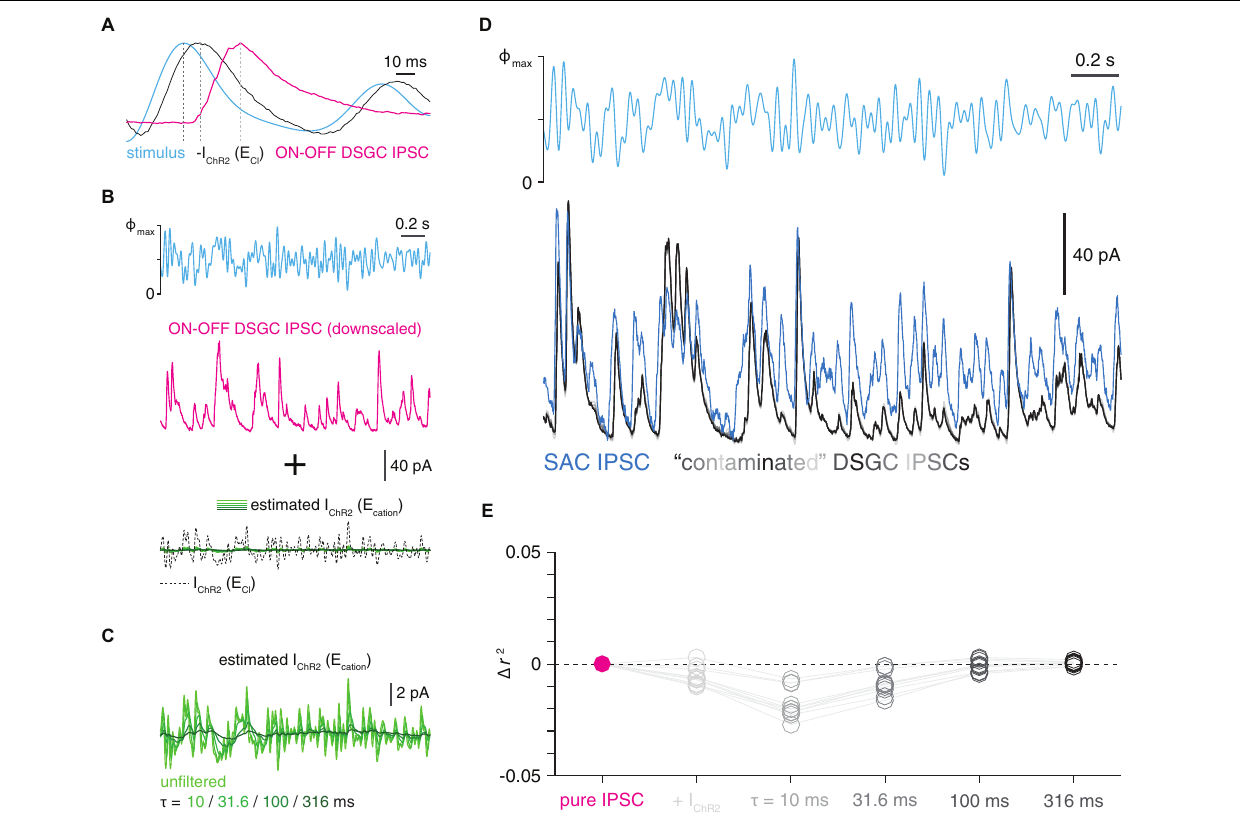
FIGURE 4 | Contamination of IPSCs by unclamped ChR2 current in voltage-clamped SACs cannot explain relatively fast transmission kinetics. (A) Comparison of time courses of optogenetic white-noise stimulus sequence (cyan), inverted ChR2 current (black), and IPSC recorded in an ON-OFF DSGC. Gray lines indicate relative peak times for each trace. Each trace is normalized to its peak. ChR2 current trace is the mean of recordings from 5 ON SACs voltage-clamped at E Cl during GABA A receptor blockade. (B) Simulating contamination of an IPSC by unclamped ChR2 current. Top , optogenetic white-noise stimulus ( (cid:56) max = 4.8 × 10 17 Q cm − 2 s − 1 ). Middle , IPSC (average of 10 repeated trials) obtained from an ON-OFF DSGC downscaled to match amplitude of an ON SAC IPSC. Bottom , family of ChR2 currents generated by downscaling ChR2 current measured at E Cl and applying a family of exponential filters (see section